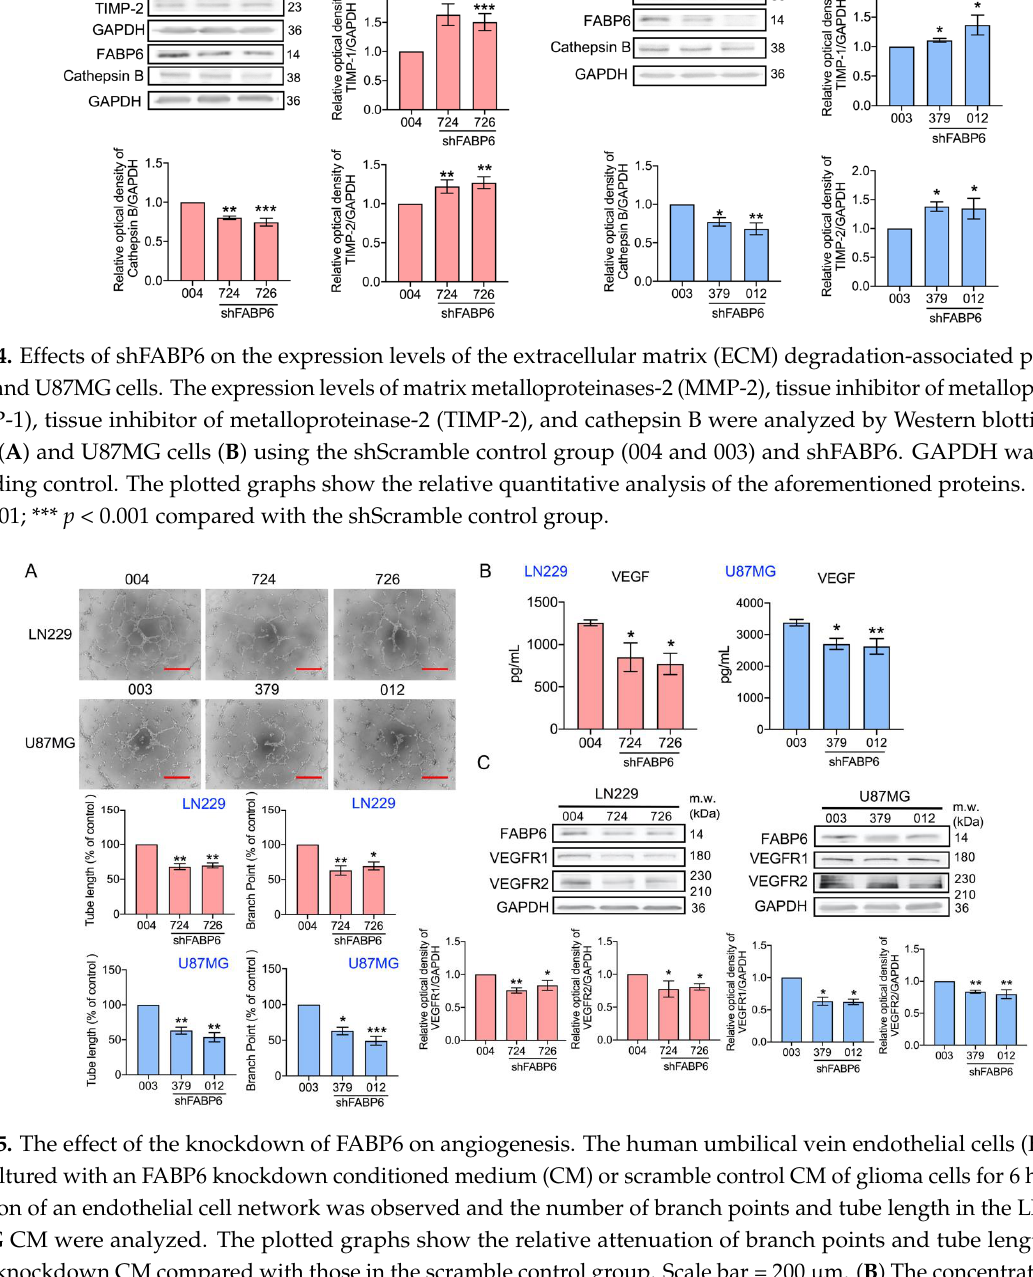
(VEGFR1) and vascular endothelial growth factor receptor 2 (VEGFR2) were analyzed by Western blotting in the LN229 of vascular endothelial growth factors (VEGFs) in the CM of LN229 and U87MG cells were analyzed by the enzyme-linked and U87MG cells using the shScramble control group and shFABP6. GAPDH was used as the loading control. The plotted immunosorbent assay (ELISA). ( C ) The expression levels of the vascular endothelial growth factor receptor 1 (VEGFR1) graphs show the relative quantitative analysis of the aforementioned proteins. * p < 0.05; ** p < 0.01; *** p < 0.001 compared